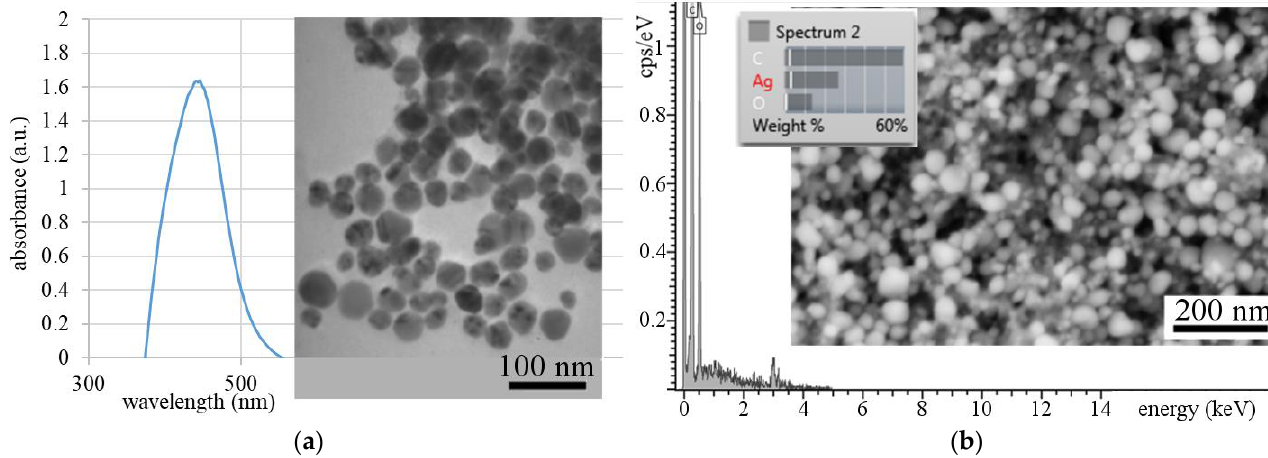
Figure 2. The UV–vis absorption spectrum of the AgNPs colloid, TEM micrograph of the AgNPs, and particle size histogram superimposed on the TEM image ( a ); SEM image and EDX analysis of the AgNPs ( b ).